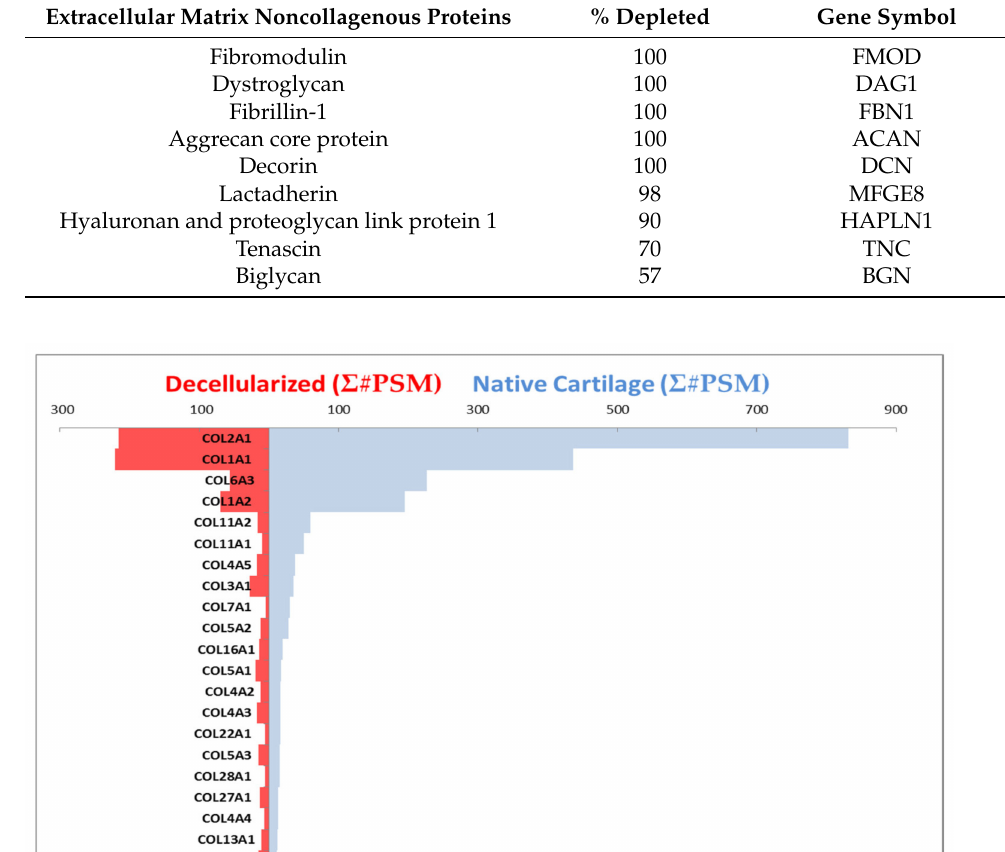
Table 4. Noncollagenous extracellular matrix proteins after decellularization.